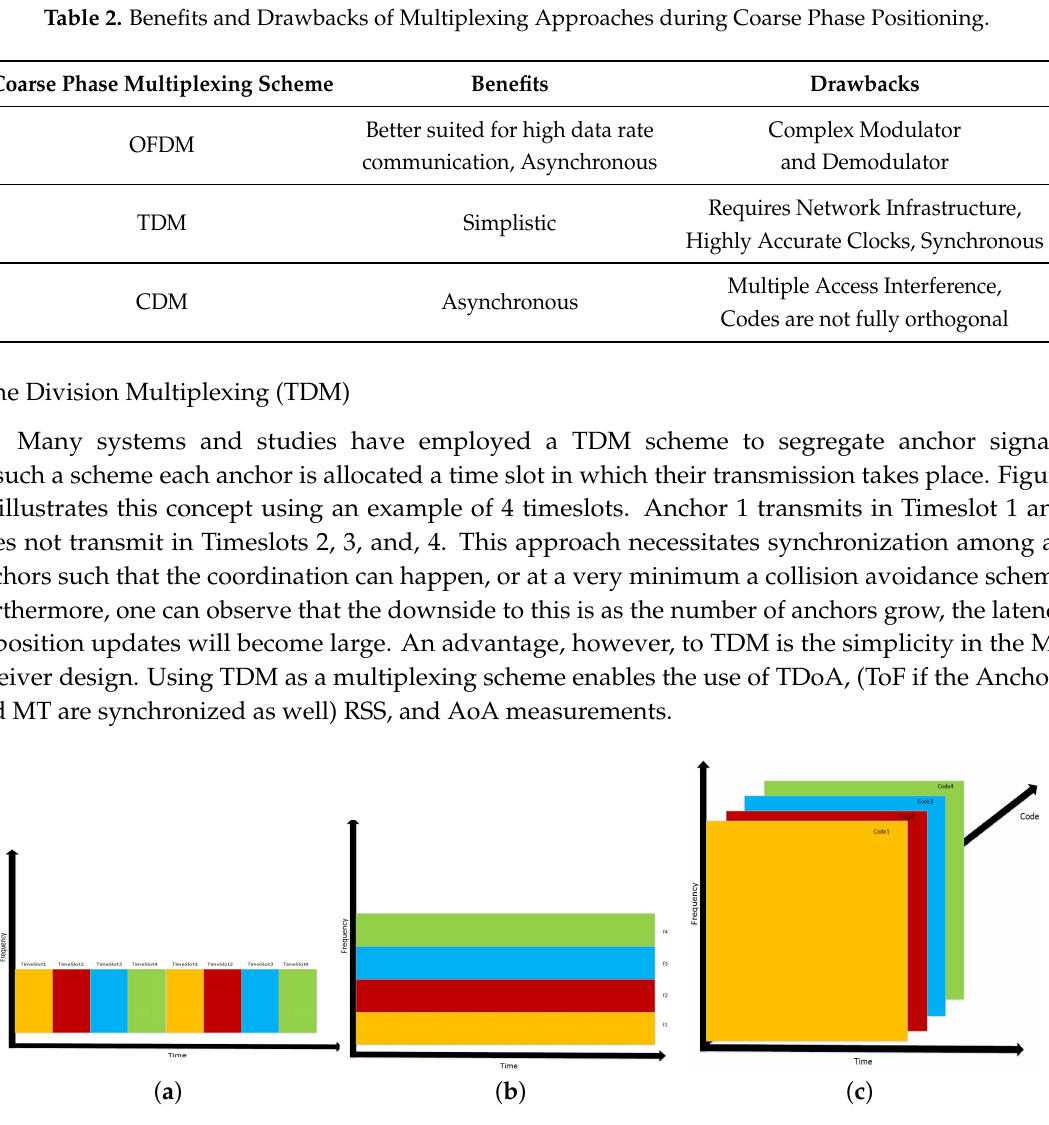
Figure 5. Model Description: ( a ) Time Division Multiplexing among 4 Timeslots; ( b ) Frequency Division Multiplexing among 4 Frequencies; ( c ) Code Division Multiplexing among 4 Spreading